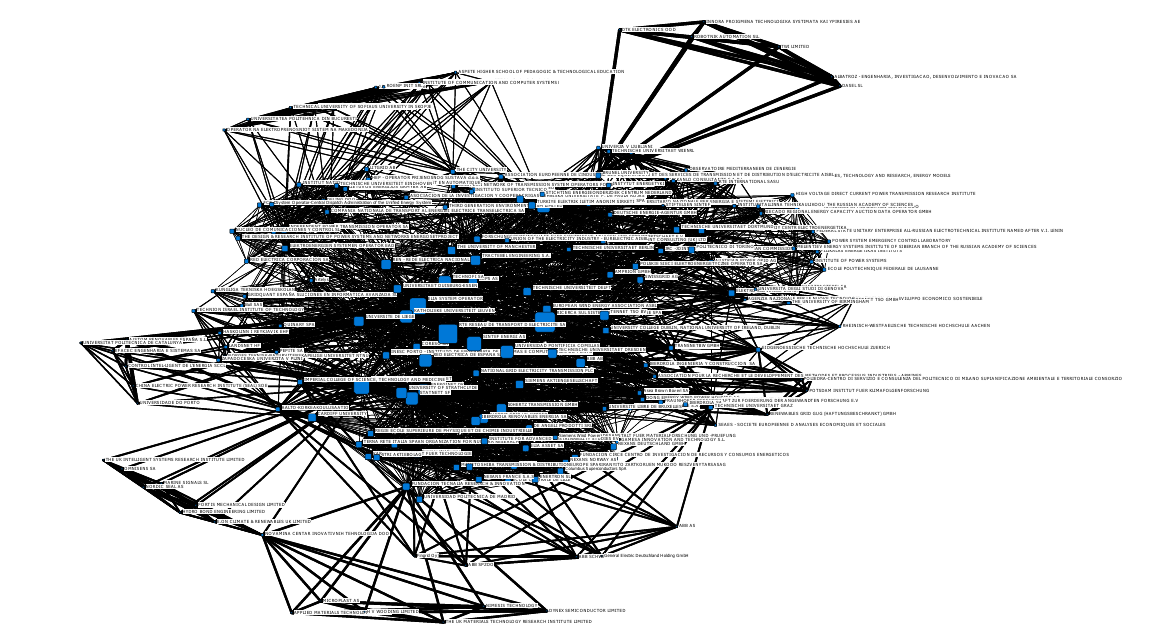
Figure 7. FP7 Transmission Grid projects. Social network based on Freeman degree centrality,